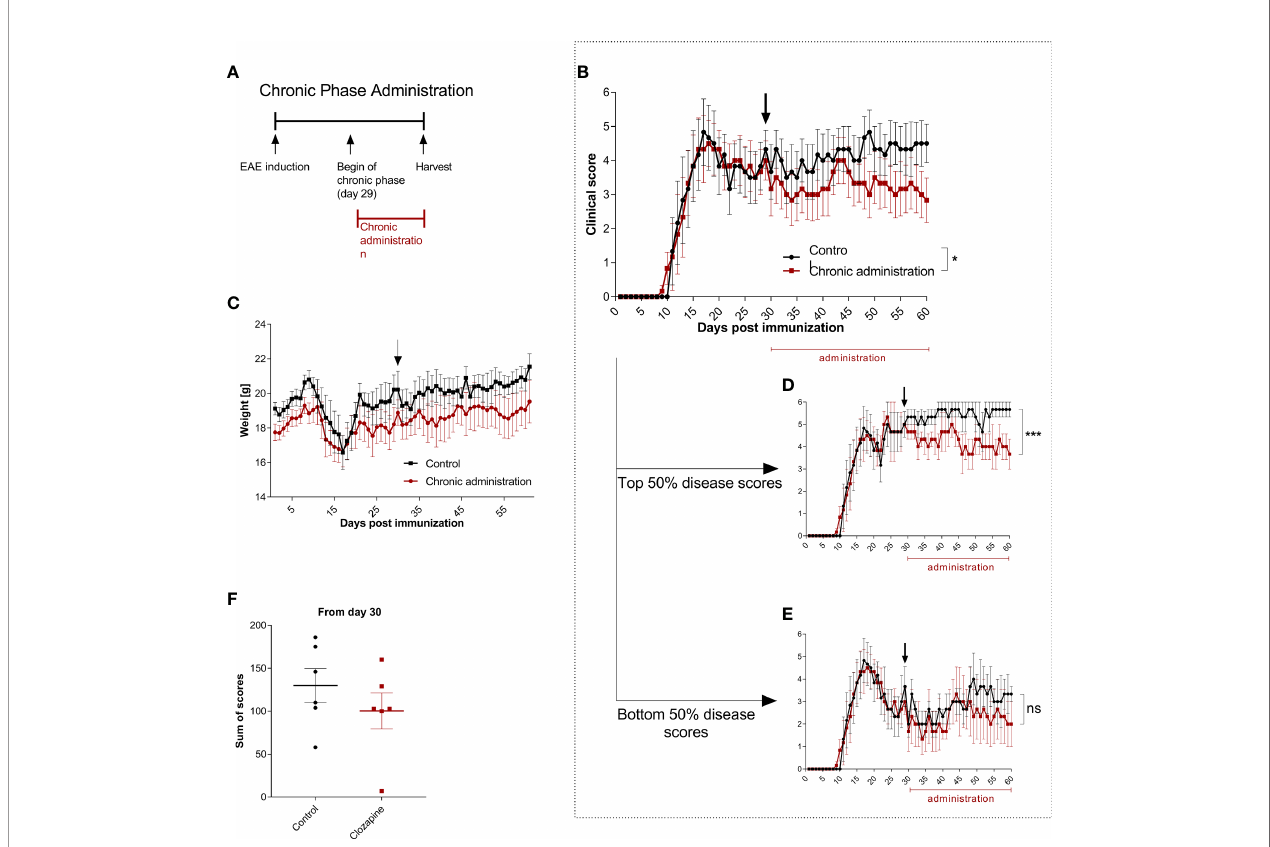
FIGURE 4 | Treatment with clozapine during chronic EAE ameliorates clinical signs with higher bene fi t in animals with higher disability. (A) MOG-immunized C57BL6/J mice (female, 8 weeks old) were treated with 5% DMSO/0.0025% acetic acid in saline (vehicle) from day 0. Animals were randomized from the chronic phase (day 29) and one group was treated with 15 mg/kg clozapine once a day. (B) The clinical condition of treated mice improved in the chronic phase compared to the control group (p = 0.0388) while (C) weight did not differ. (D) This effect was mediated by mice with higher disability (top median) which showed a decline of signs (p = 0.0005) whereas (E) the lower median did not pro fi t during the chronic phase (p = 0.1204). (F) Sums of scores in the chronic phase did not differ. Control group n = 6, chronic phase treatment group n = 6. Data are shown as mean ± SEM. Area under the curve (AUC) with unpaired t-test (B – E) and Mann-Whitney test (F) with 95% con fi dence interval. Signi fi cances are depicted as *p < 0.05, ***p < 0.001, ns: not signi fi cant